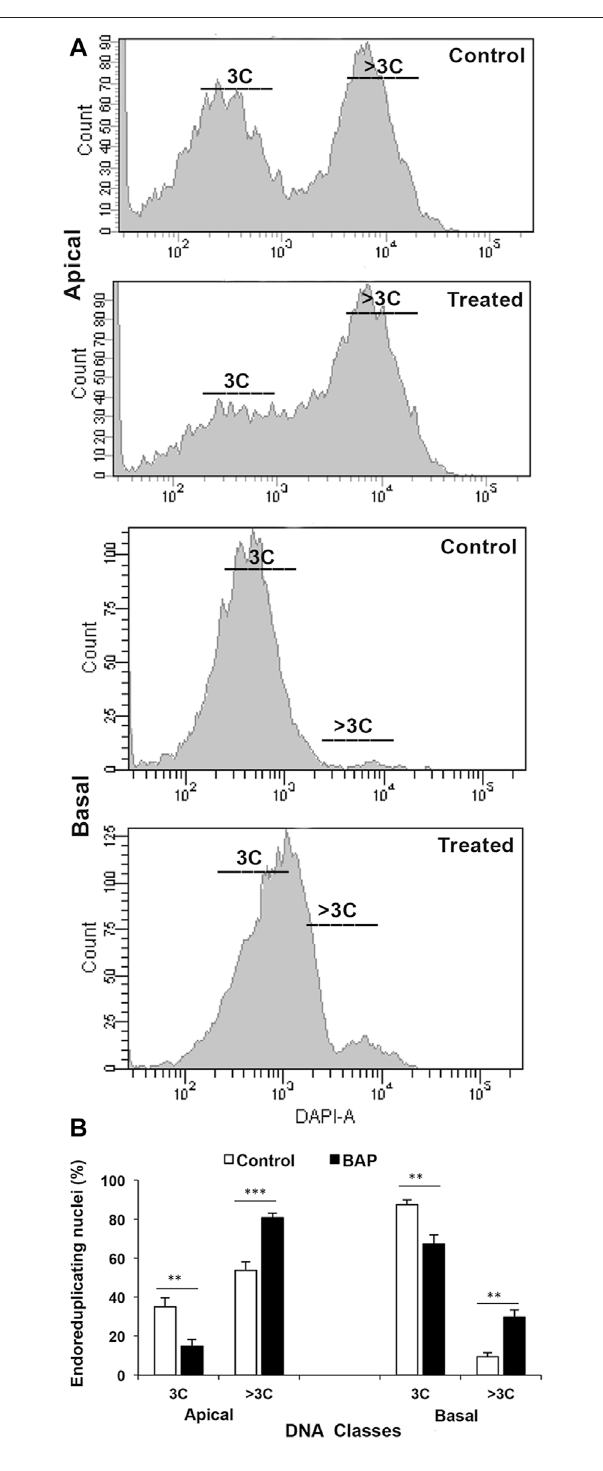
FIGURE 7 | Ploidy status (DNA class) of the endosperm nuclei of the apical and basal spikelets of a compact-panicle rice cultivar, OR-1918, sampled on the 9 days after fertilization from the control plant and that sprayed with 6-benzylaminopurine (BAP) during the heading. (A) The endosperm nuclei ploidy status is much lesser in the caryopses of the basal